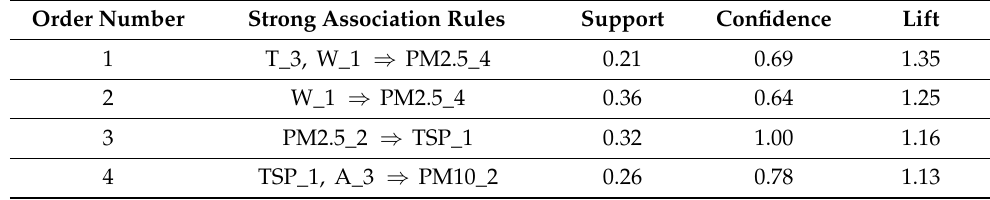
Table 11. Strong association